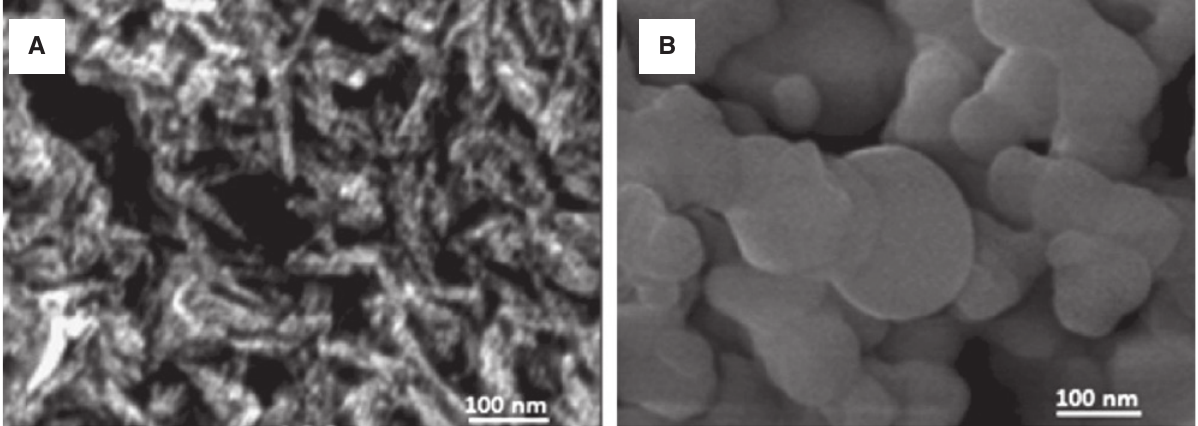
Figure 2: SEM images of as-prepared (A) and heat-treated (B) phase-pure hydroxyapatite nanorods prepared by using method 1 based on calcium nitrate and diammonium hydrogen phosphate precursors with bar size 100 nm.